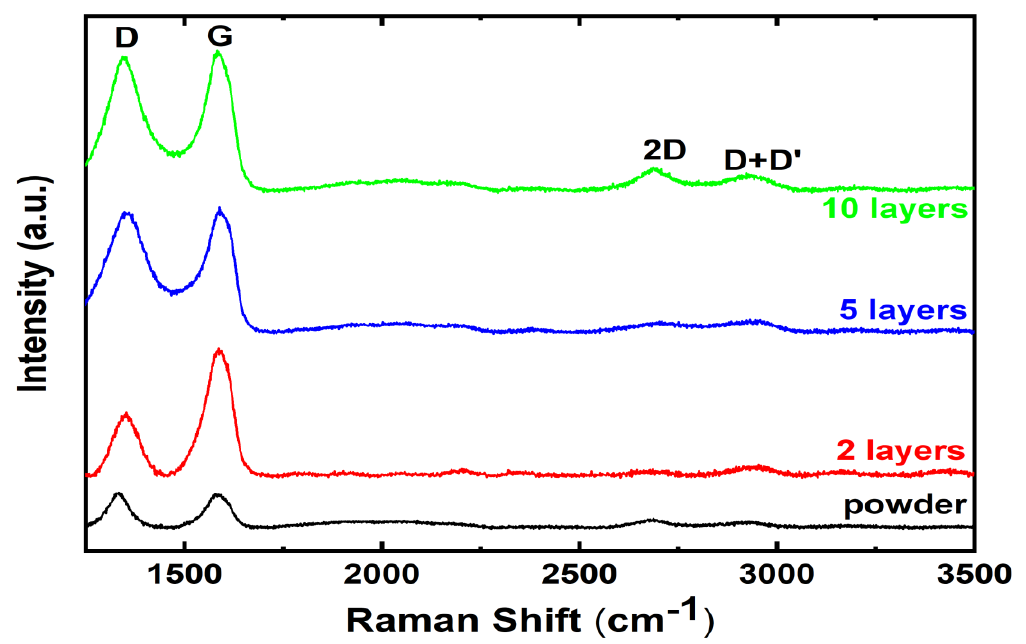
Figure 4. Raman spectra of printed NDG flakes compared with NDG powder.